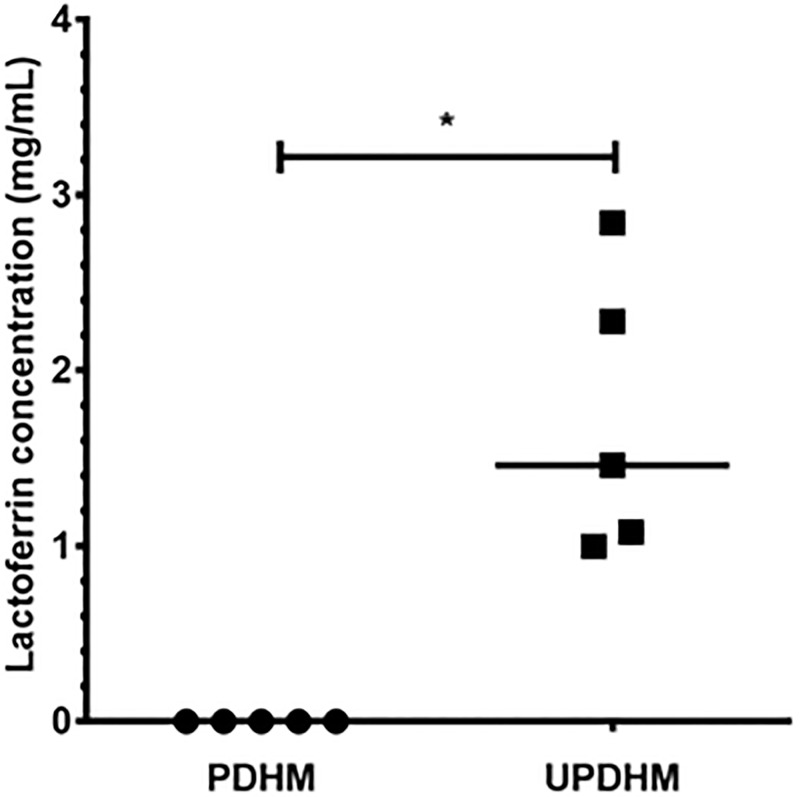
Detectable lactoferrin (Lf) in pasteurised (PDHM) and unpasteurised (UDHM) donated human breast milk samples.Data expressed as mg/mL of Lf. Where there were undetectable quantities of Lf, samples were given an arbitrary value of 7.8125x10-4 mg/mL Lf, which was the lowest point detected on the standard curve. Data show median (n = 5), *p <0.05 Wilcoxon matched-pairs signed rank test.